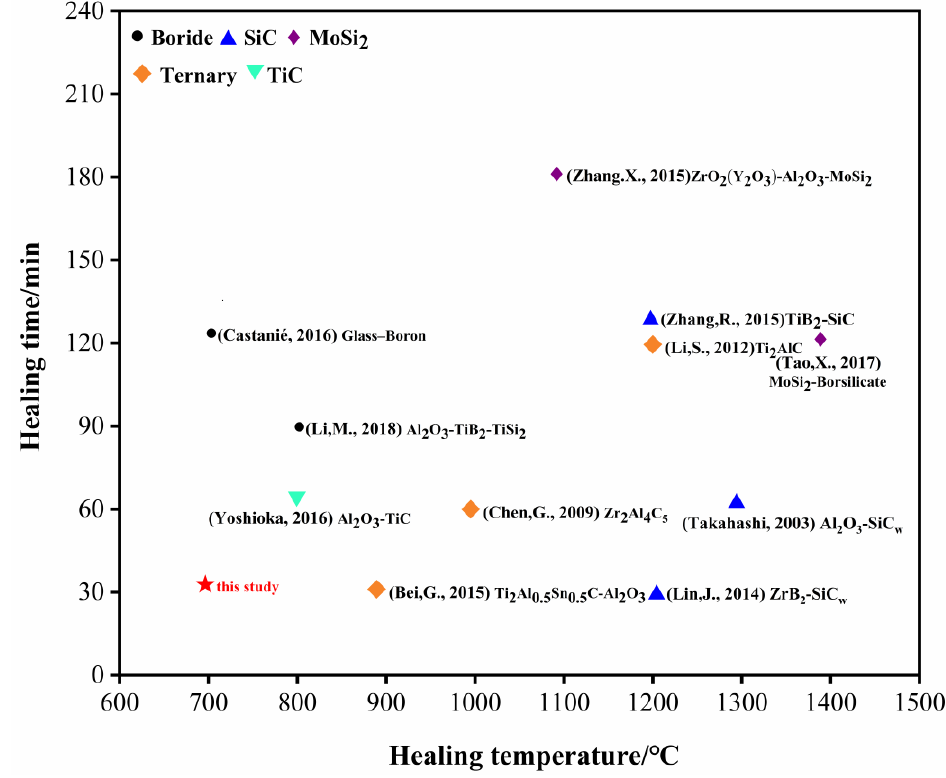
Figure 12. Time and temperature of crack healing in ceramic composites with different systems Figure